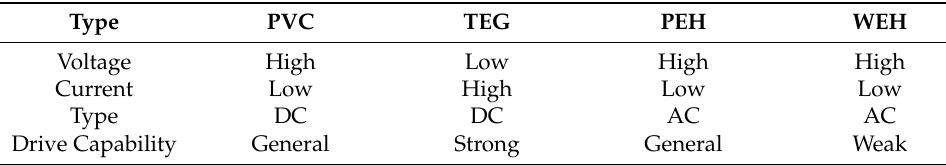
Table 1. Classifications of Energy Sources. Type PVC TEG PEH WEH Voltage High Low High High Current Low High Low Low Type DC DC AC AC Drive Capability General Strong